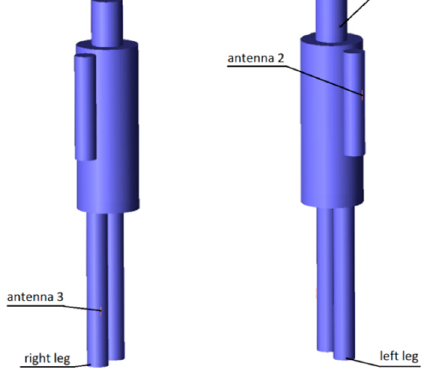
Figure 14. The initial radiation patterns.